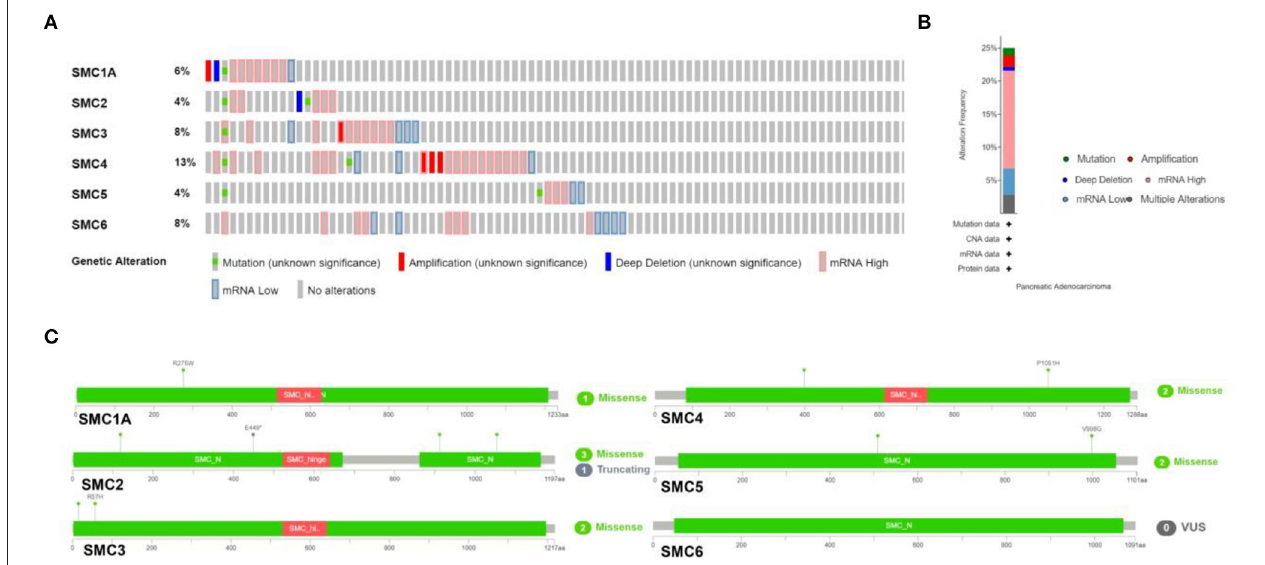
FIGURE 3 | Mutations in SMC genes in PAAD, as determined using cBioPortal. (A,B) Summary of mutation frequency in SMC family genes in PAAD. (C) Specific types of mutations in individual